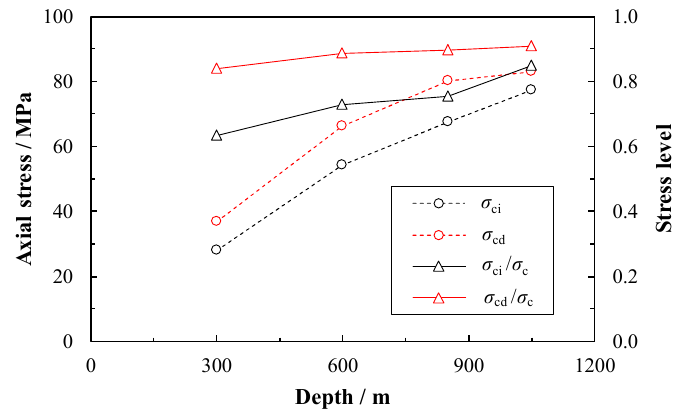
Figure 14. Crack initiation stress σ ci and crack damage stress σ cd of coal samples at different depths.